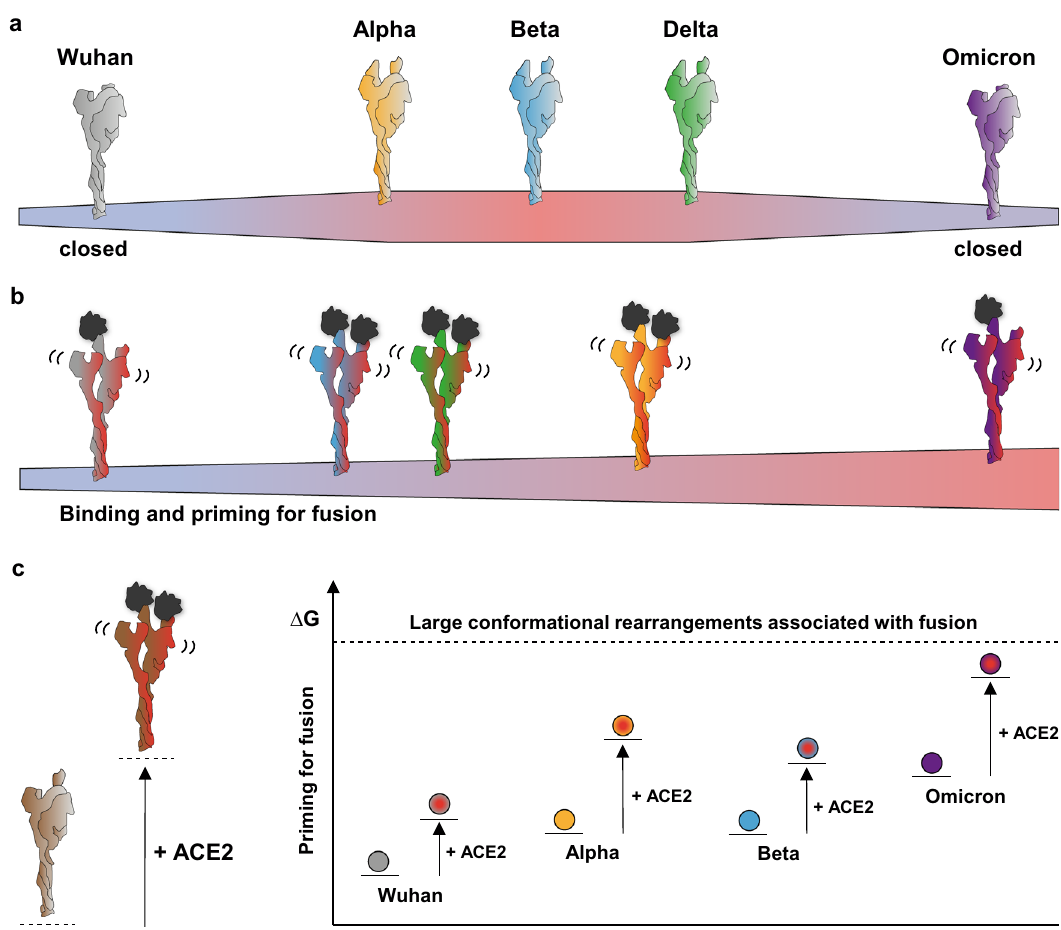
Fig. 7 | Schematic of the structural transition of prefusion spikes. a Preference for the open state of spikes: Wuhan and omicron spikes favour the closed state, whereas alpha, beta and delta spikes favour the open state. b Priming of spikes upon binding to the ACE2 receptor: alpha, beta and delta spikes bind ACE2 with higher avidity and prime for fusion better than Wuhan spike; omicron spike is primed for fusion better than the other variant spikes and with minimal receptor